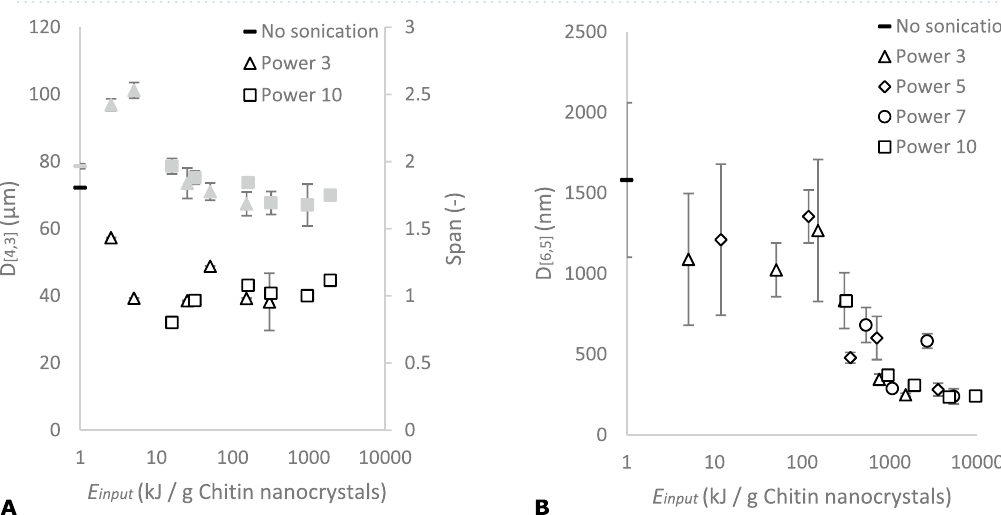
Figure 5. The volume % as function of chitin nanocrystal size at different E input measured with ( A ) laser diffraction and ( B ) dynamic light scattering.